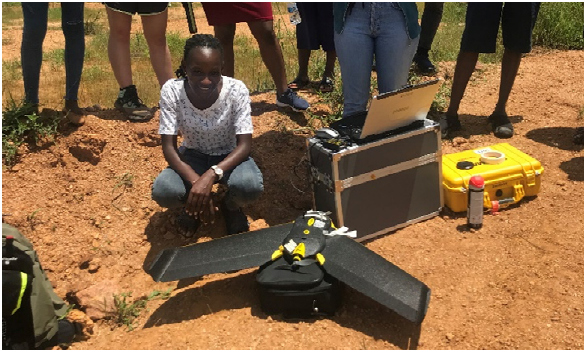
Figure 6. Training session during the ADDA workshop on the use of UAV.